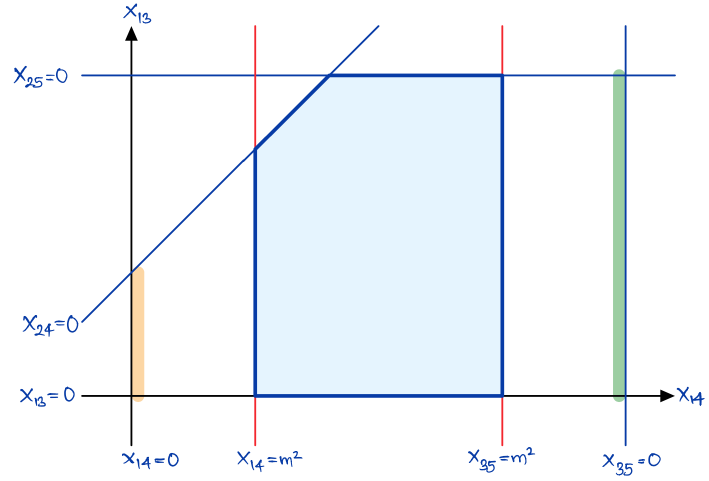
Figure 10 . Acoordiohedra from Associahedra. The Orange strip is the region with X 14 (cid:28) m 2 where we get the accordiohedron (24 , 13) , and the green strip is the region with X we get the accordiohedron (13 , 25)